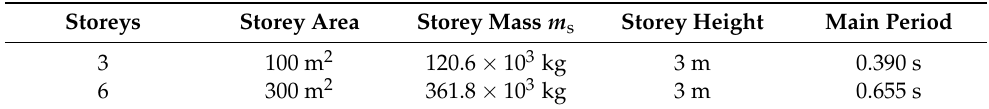
Table 1. Geometric and mechanical characteristics of the two reference multi-degree-of-freedom frames (M-DOF).